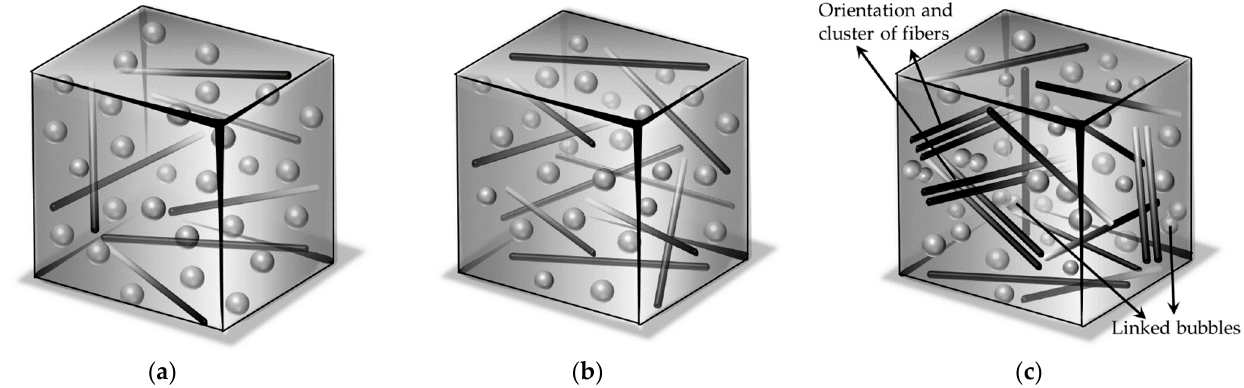
Figure 12. Schematic diagrams of distributions of bubbles and 15.0 mm chopped glass fiber: ( a ) with the presence of 10.00 phr, ( b ) with the presence of 15.00 phr, ( c ) with the presence of 25.00 phr in cured samples.